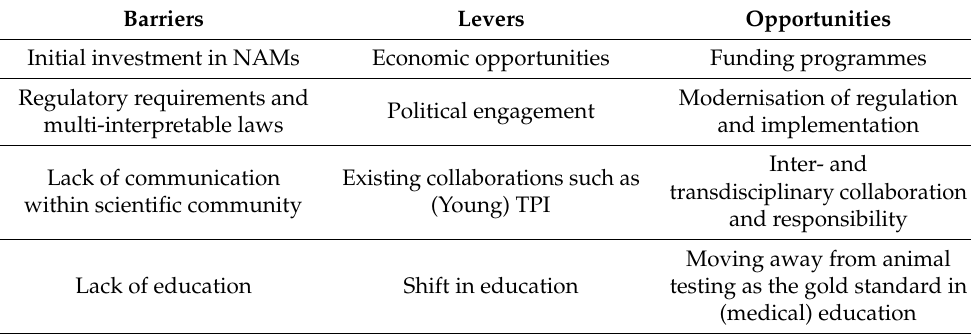
Table 2. Barriers, levers, and opportunities at the regime